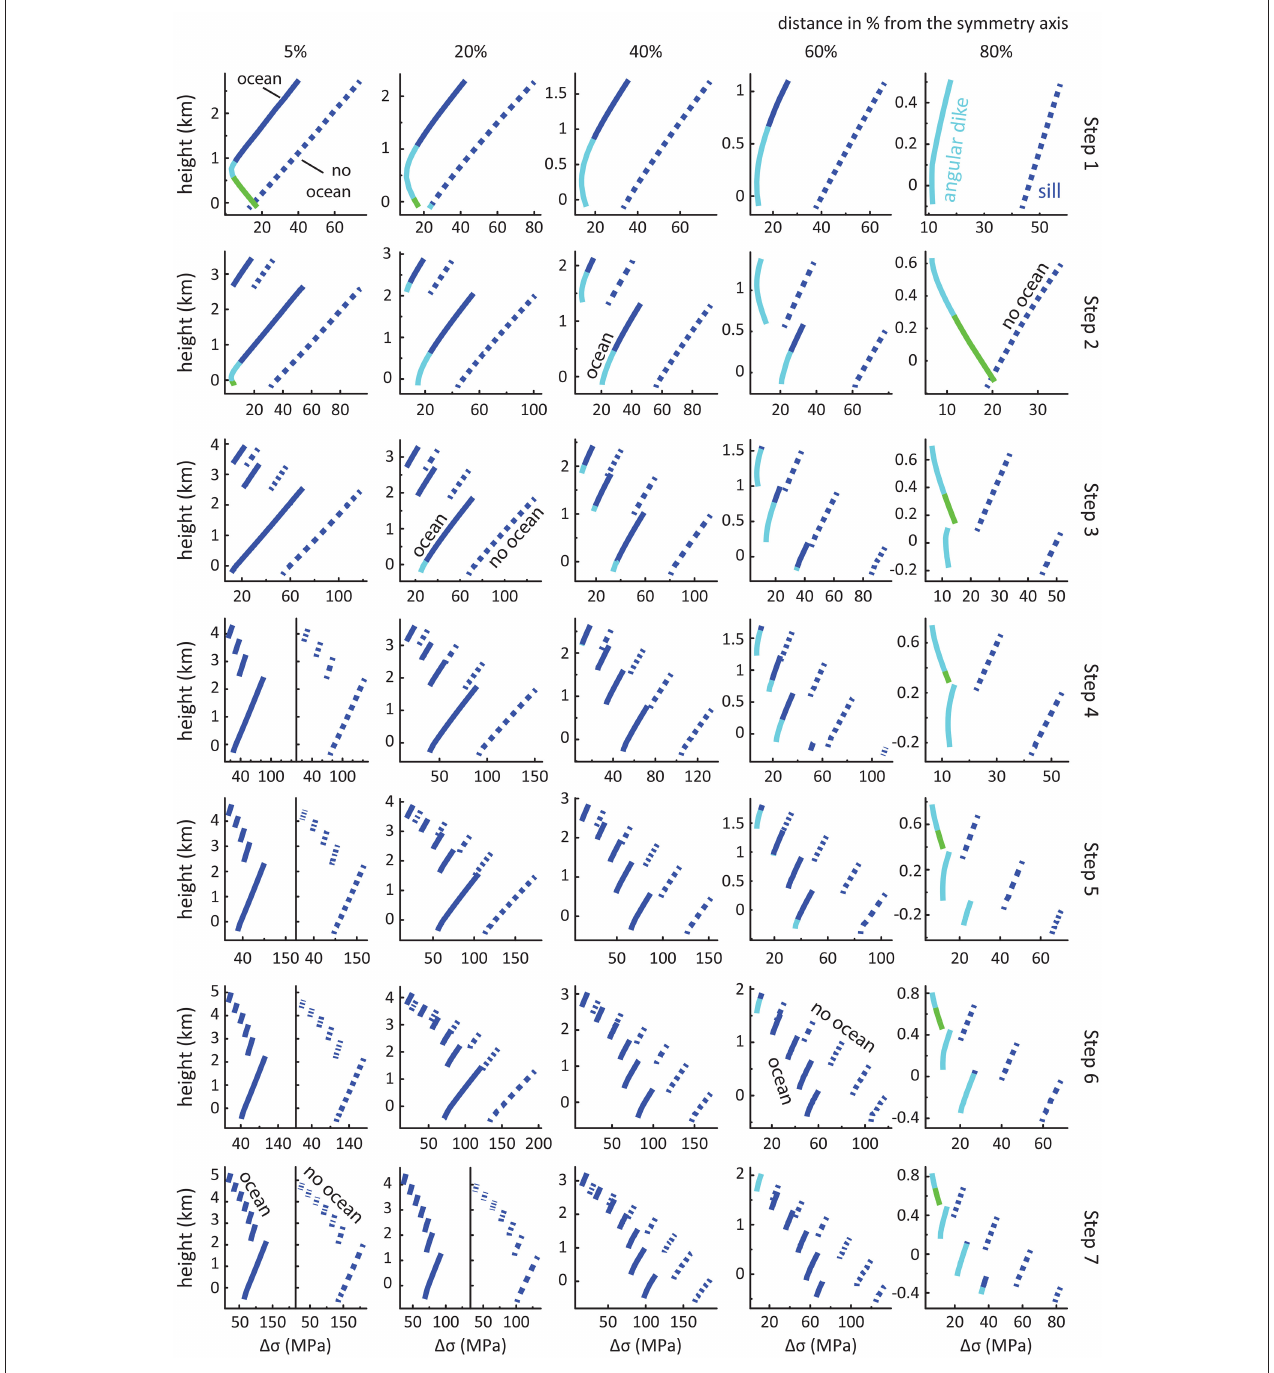
FIGURE 7 | Differential stress magnitudes, and magmatic intrusion types predicted from principal stress orientations along the internal cross-sections for incrementally-grown volcanoes in flexure models with and without an ocean load (solid and dashed lines, respectively). Legend as in Figure 3 .